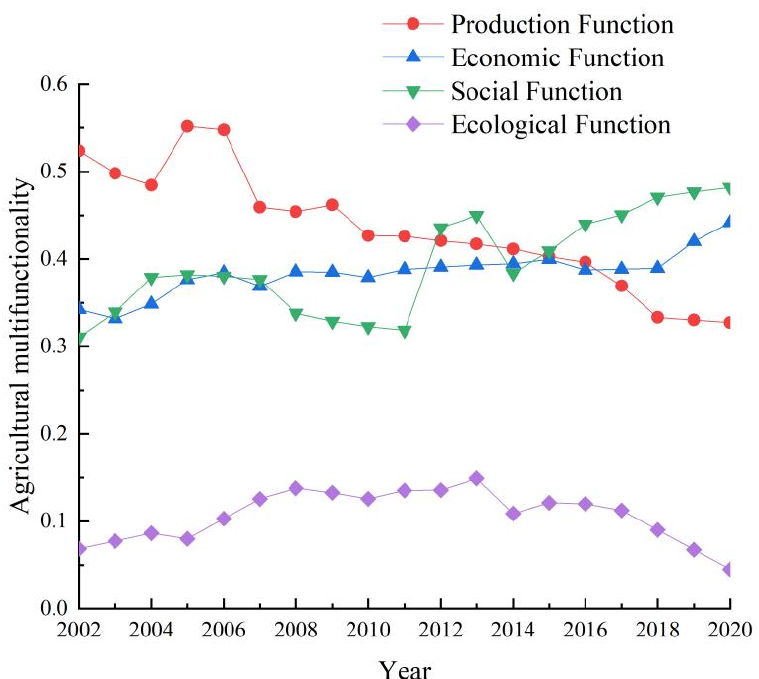
Figure 3. Urban agricultural multifunctionality in Guangzhou from 2002 to 2020.